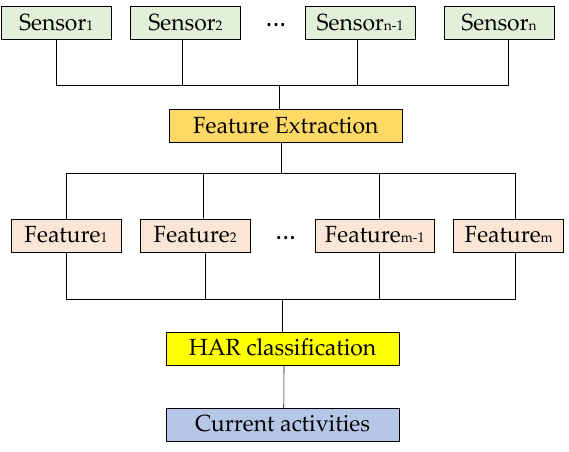
Figure 4. Typical flowchart of a HAR system.